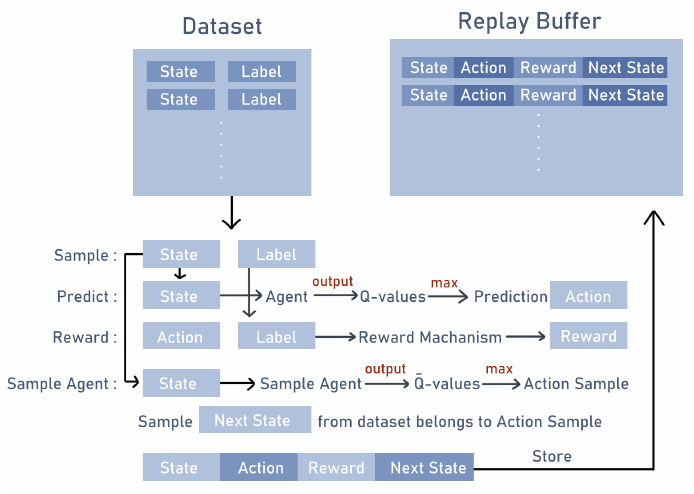
Figure 5. Interaction Module.